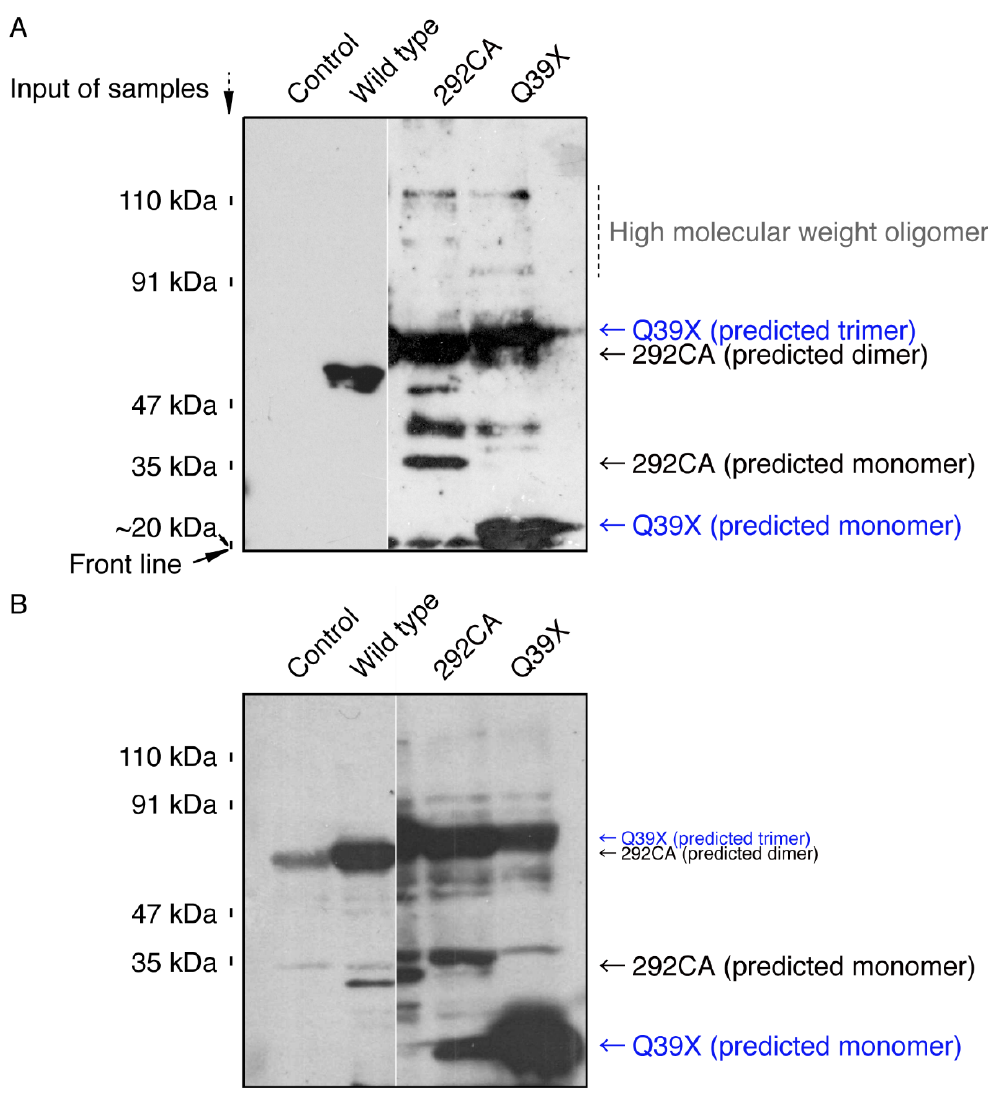
Figure 8. The 292CA or Q39X mutant proteins exhibit oligomeric forms in a non-denatured gel. 293T cell lysates expressing the wild type AIMP1 proteins with GFP-tag or the 292CA or Q39X mutant proteins were subjected to a non-denaturing polyacrylamide gel ( A ) or a denaturing polyacrylamide gel ( B ). Blotted membranes were incubated with an anti-GFP antibody. In a non-denatured polyacrylamide gel, the wild type proteins mainly corresponded to a monomeric form whereas the mutant ones exhibited molecular weights characteristic of dimeric proteins at least. Aggregated proteins appear as thick as the electrophoresis